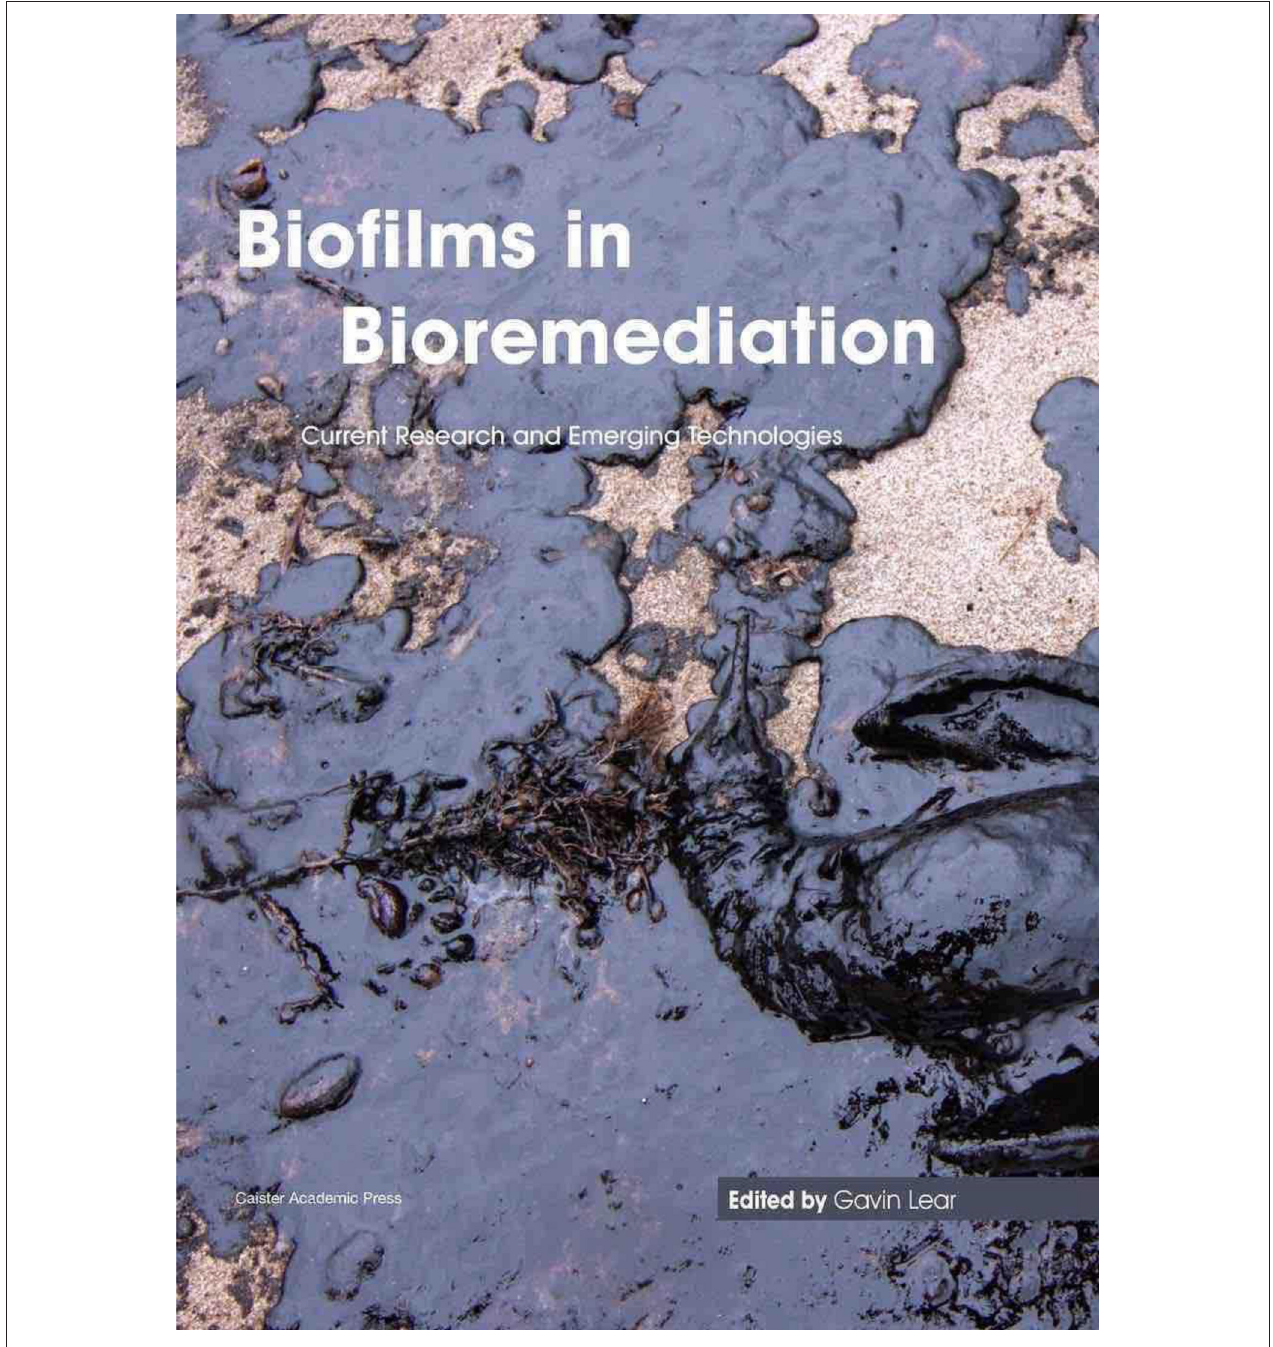
FIGURE 1 | Book covering